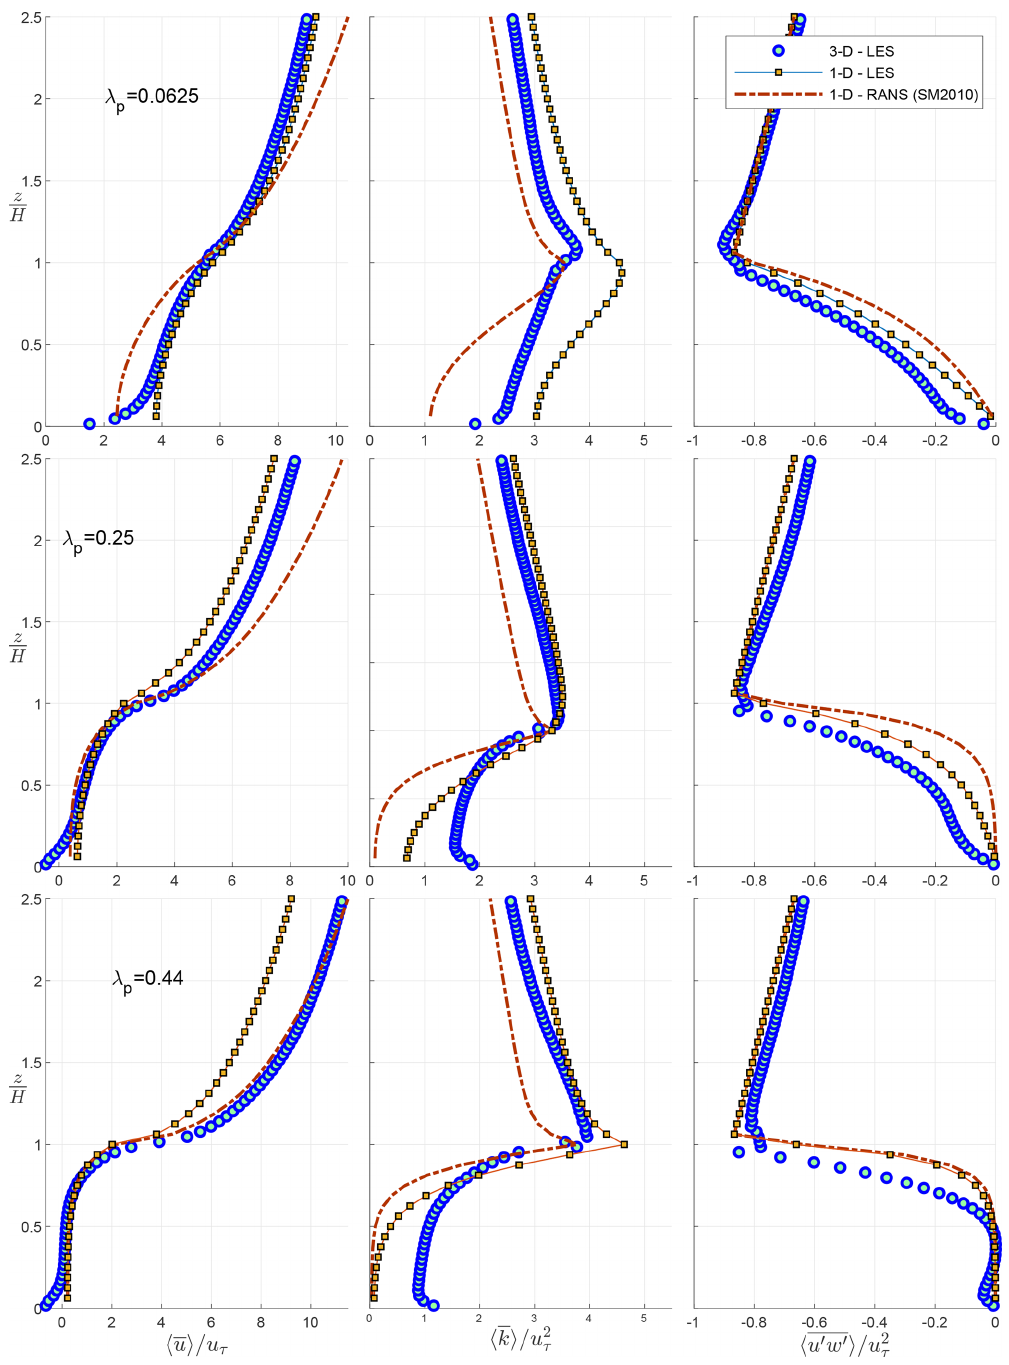
(cid:16) (cid:17) (cid:104) k (cid:105) /u 2 , and turbulent momentum flux τ